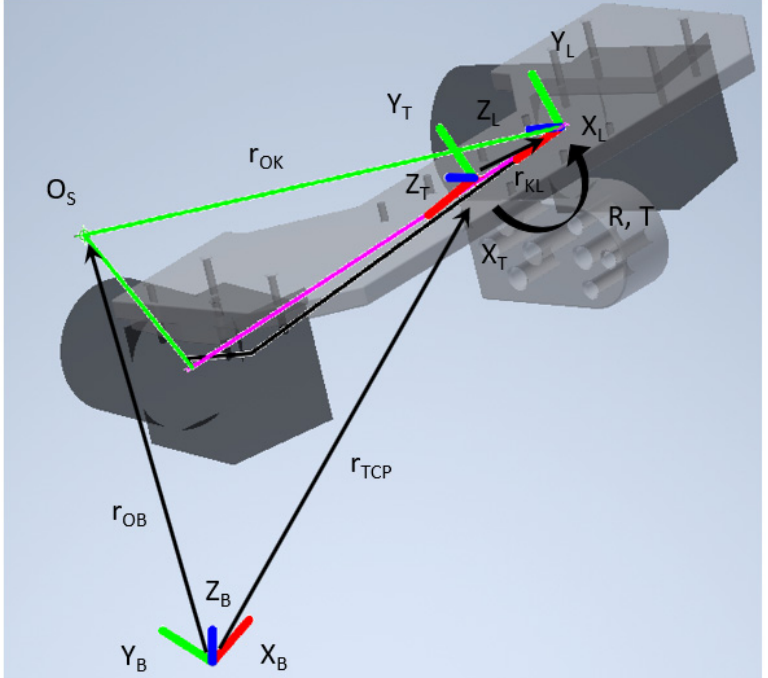
Figure 7. Spatial position measurement model of a point on a robotic workstation using a stereo-vision system.